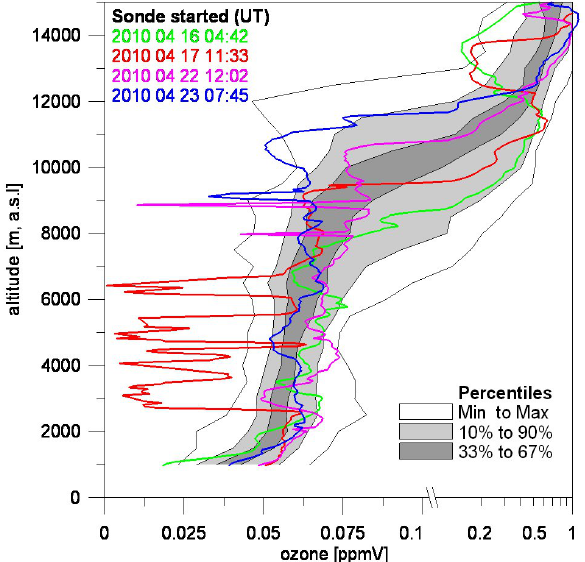
Fig. 7. Ozone profiles derived from ozone sondes launched at Ho- henpeissenberg between 16 and 23 April. On 17 April the ozone content between 2.5km and 7km is largely reduced within sev- eral distinct layers (red curve). Grey-shaded areas show the 10–90 and 33–67 percentiles of all April measurements of years 2007 to 2009, respectively. An undisturbed ozone profile was observed on 14 April (green) while the ozone profiles of 22 April (magenta) and 23 April (blue) showed layers with sharply dropped ozone concen- trations between 8km and 9km.